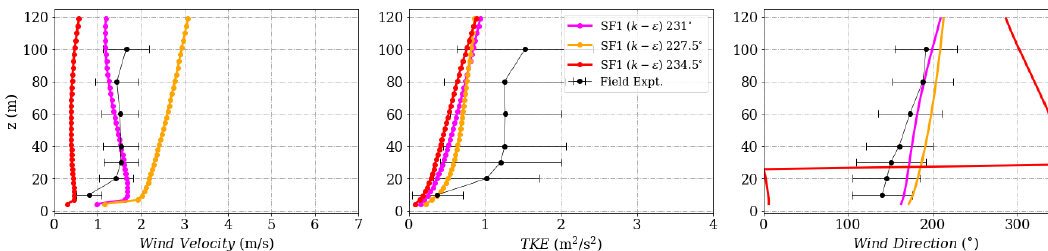
Figure 20. Simulation results and experimental data wind velocity inside the valley for Tower 25 (tse09).